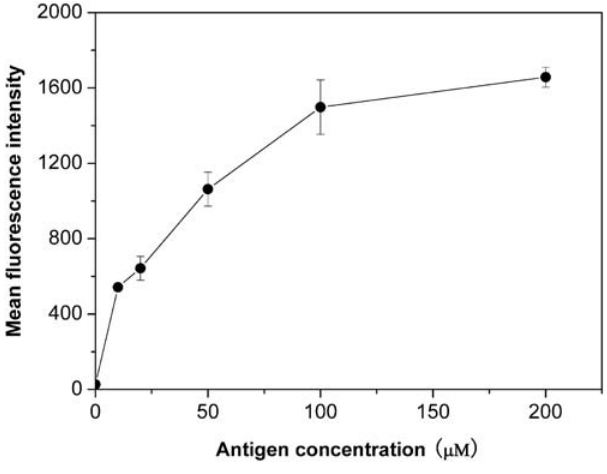
Figure 2. Direct binding of FITC-labeled TP5 to EBV-transformed B cells. The mean binding data for various concentrations of FITC-labeled TP5 were shown as mean fluorescence intensities of triplicates 6 SD.